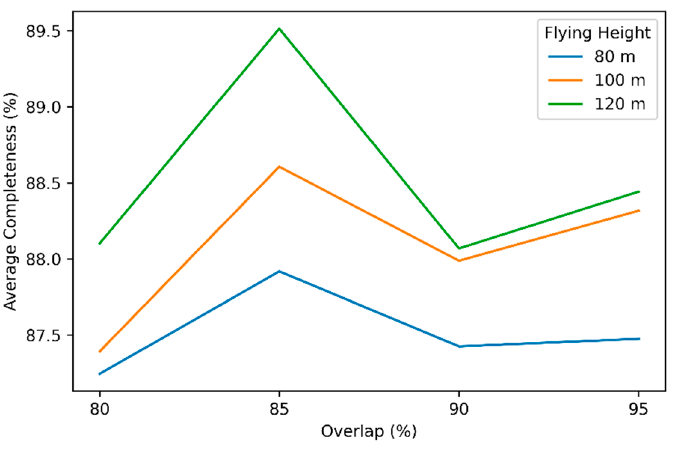
Figure 2. Change in the average completeness with forward overlap and flying height.